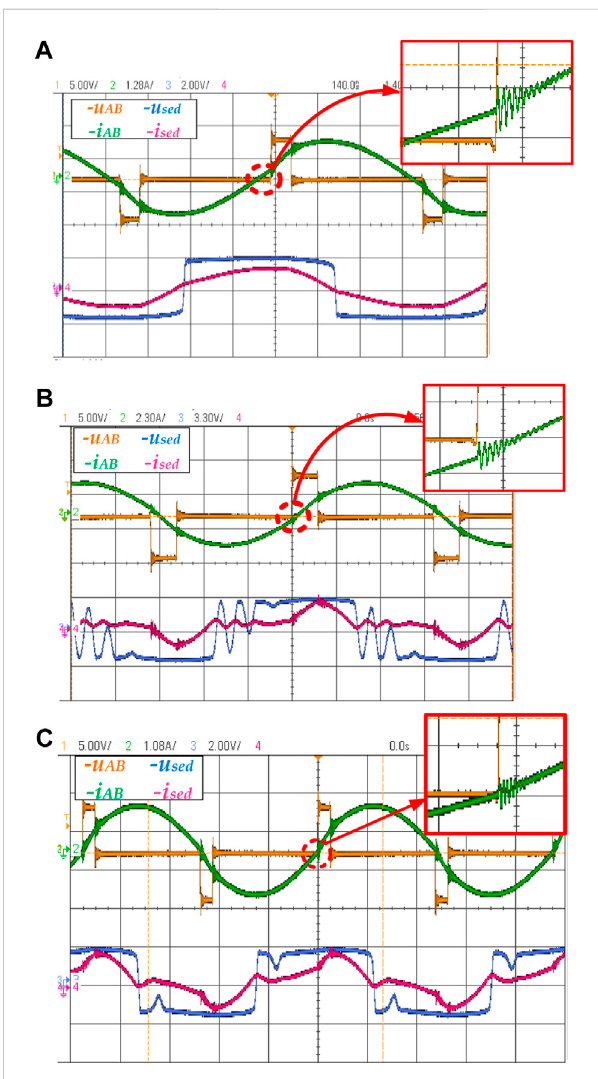
Figure 19 is obtained according to the measured data. The left and right values of the table represent the mutual inductor values between the coils at various distances. It can be seen that when the coil distance primary side switch tube to achieve soft switching.